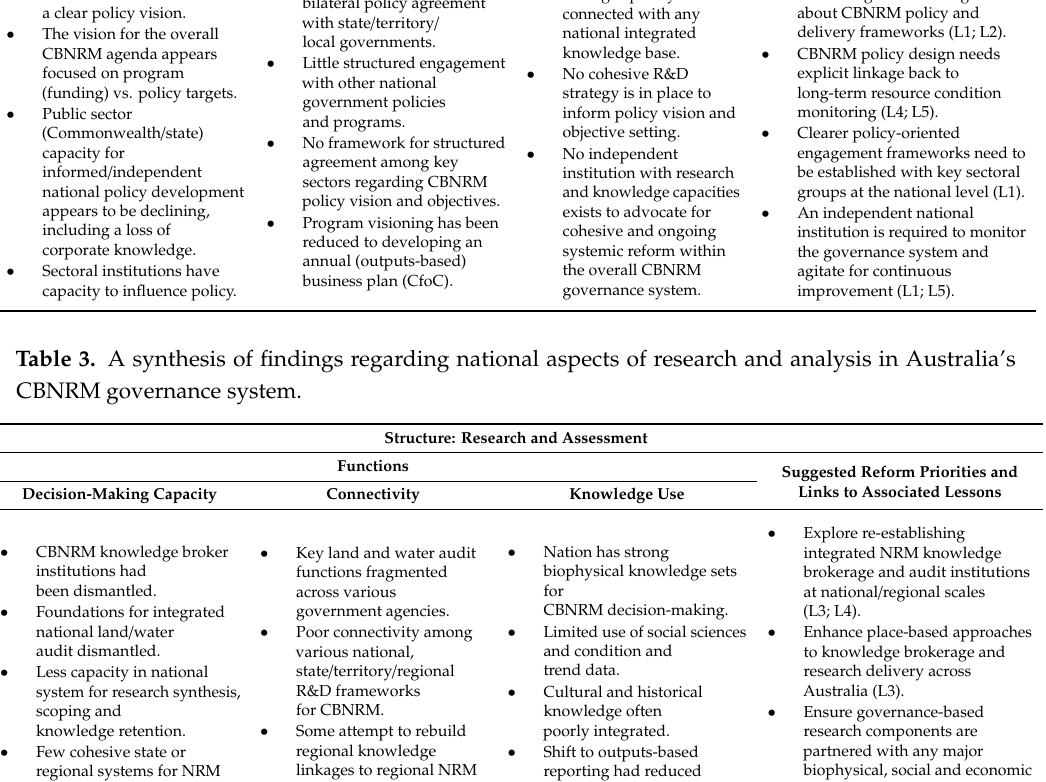
research synthesis.